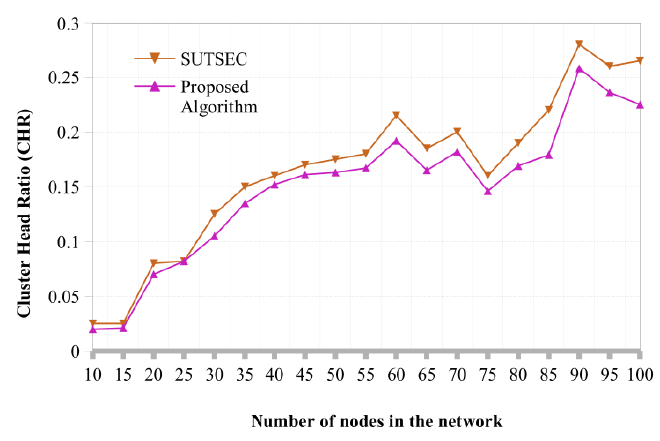
Figure 4. Performance analysis of cluster head selection algorithm.